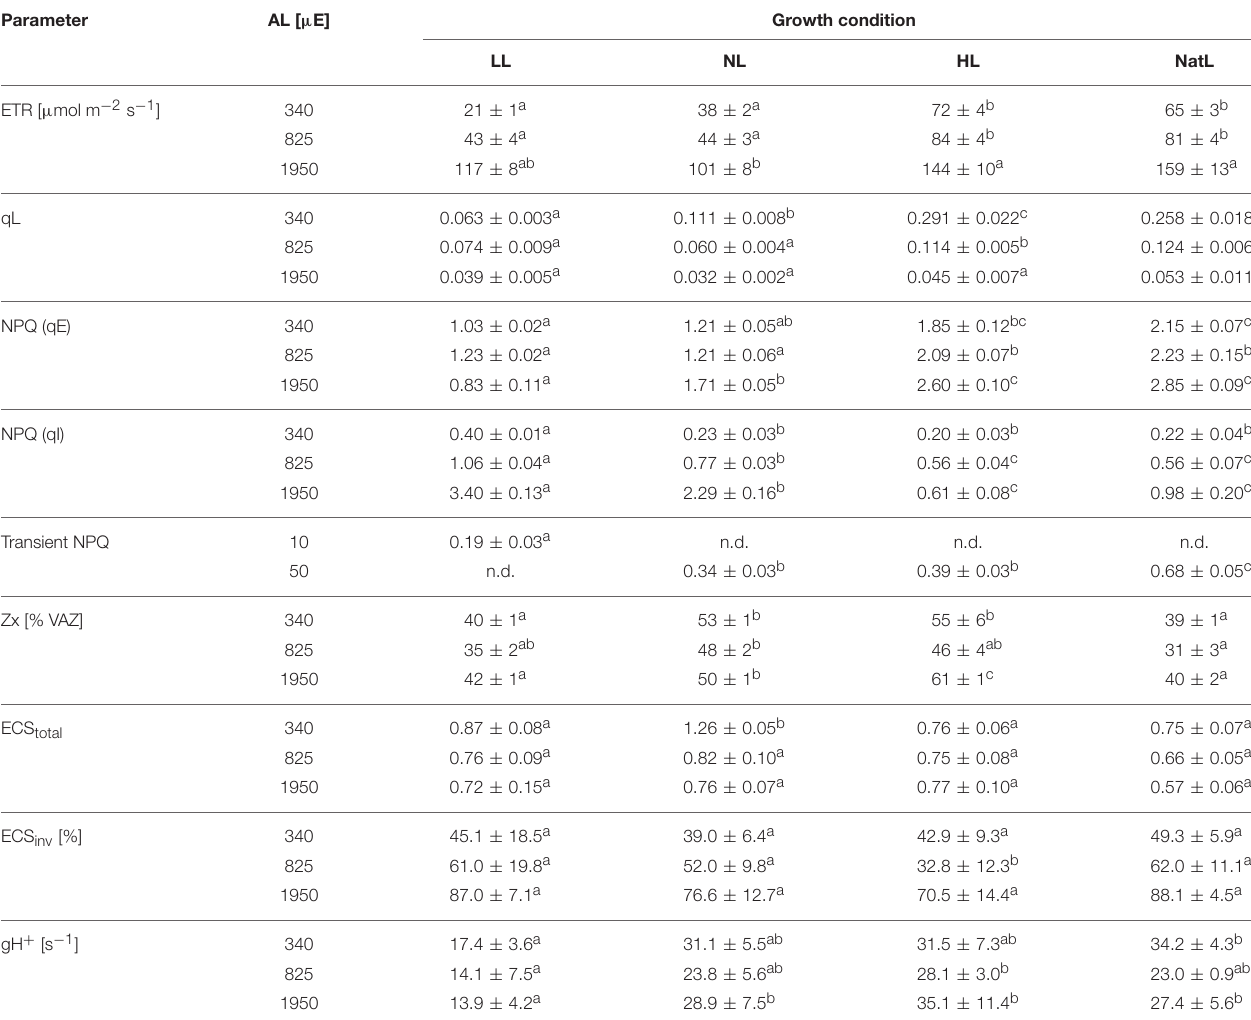
TABLE 3 | Light utilization parameters at the end of 30 min illumination at three actinic light (AL) intensities: 340, 825, and 1950 µ mol photons m − 2 s − 1 ( µ E).